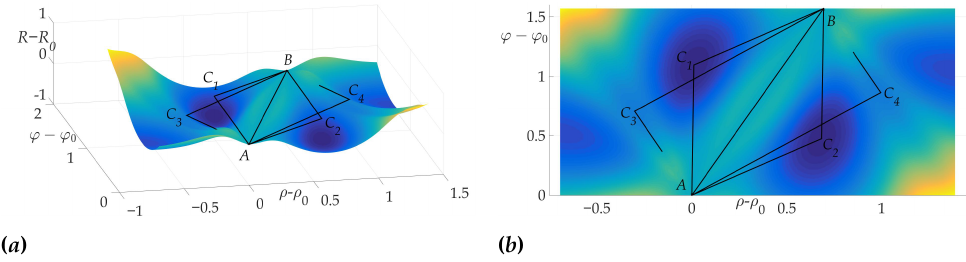
Figure 17. Optimal trajectory in ( ρ − ρ 0 , ϕ − ϕ 0 , R − R 0 ) space ( a ) and its projection on ( ρ − ρ 0 , ϕ − ϕ 0 ) plane ( b